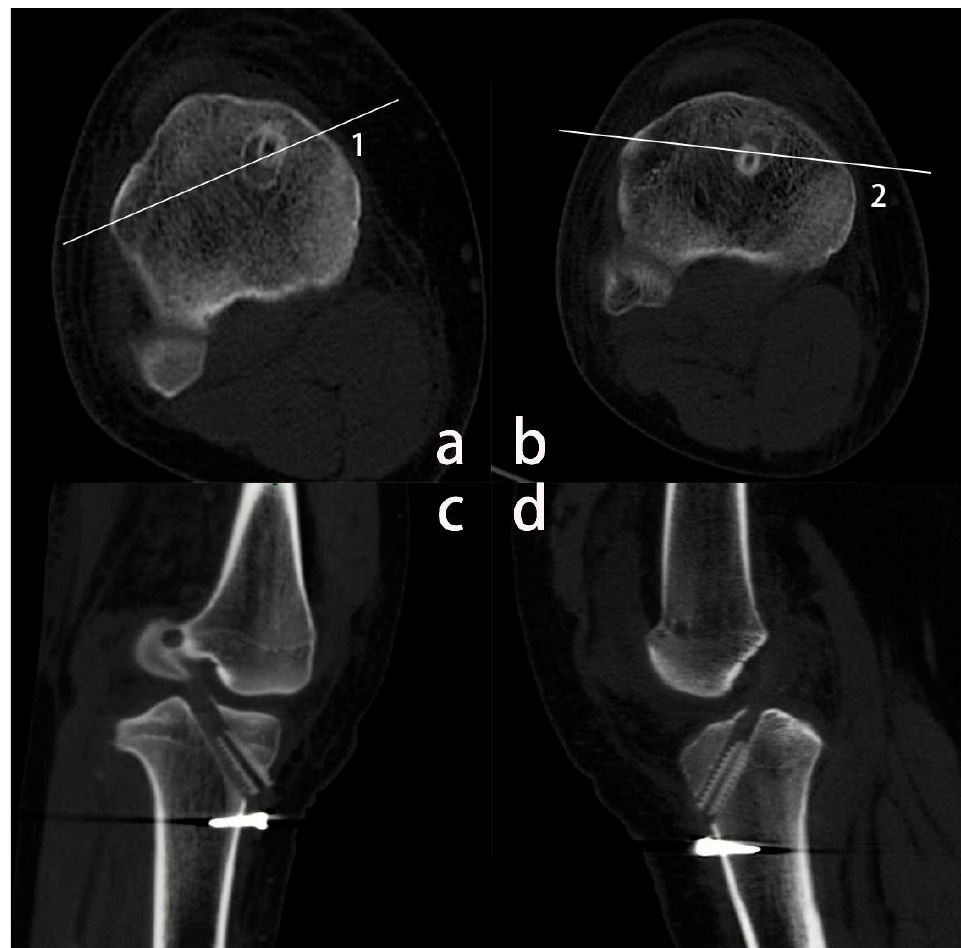
Figure 2. Knee CT imaging within 3 days after the operation. ( a – d ) belong to different patients, respectively. Line 1 and 2 are made through the center of the tibial tunnel and parallel to the posterior condylar line. ( a ), most of the screws (>50%) are in front of the line 1. ( a , c ) show that the patient’s tibial interference screw is located in the front of the tunnel. ( b ), most of the screws (>50%) are behind the line 2. ( b , d ) show that the screw is at the back of the bone tunnel.